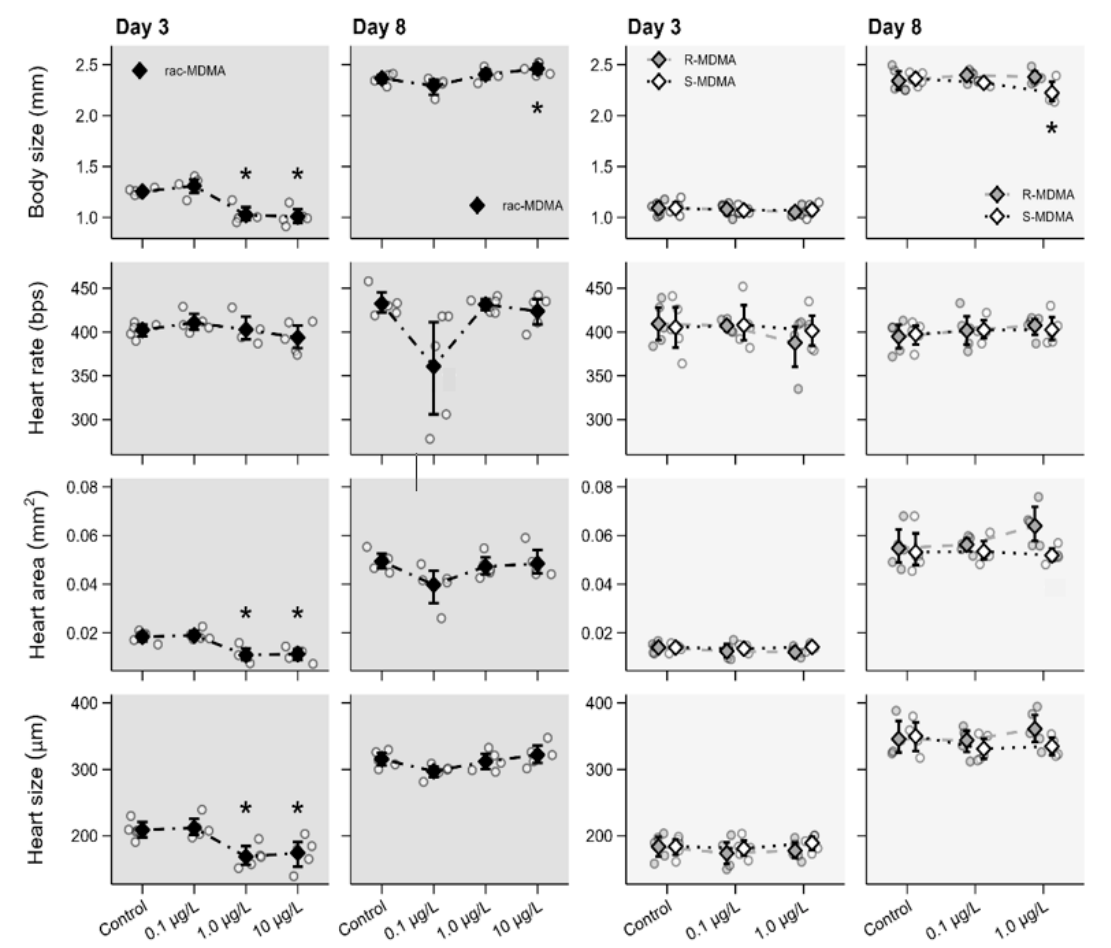
Figure 4. Morphophysiological effects of ( R,S )-MDMA ( left ; dark grey panels) and its enantiomers ( right ; light grey panels) determined on days 3 and 8 in Daphnia magna . Data are presented as individual observations (circles), mean values (diamonds) and 95% bootstrap confidence intervals (error bars). Asterisks (*) represent significant differences relative to the control.